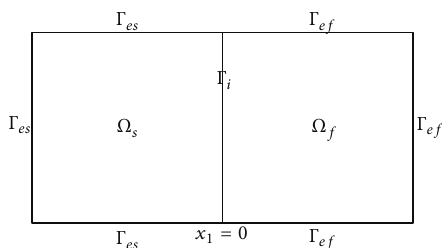
Figure 1: The domain Ω is divided into the solid part Ω 𝑠 and the fluid part Ω 𝑓